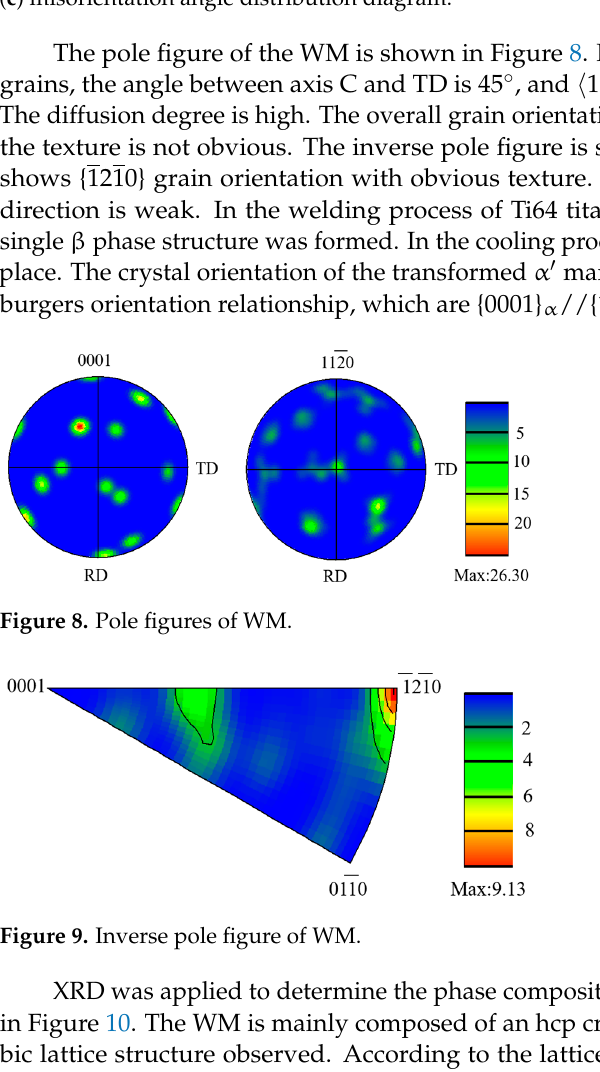
Figure 7. EBSD orientation images of WM: ( a ) grain morphology; ( b ) grain orientation diagram; ( c ) misorientation angle distribution diagram.